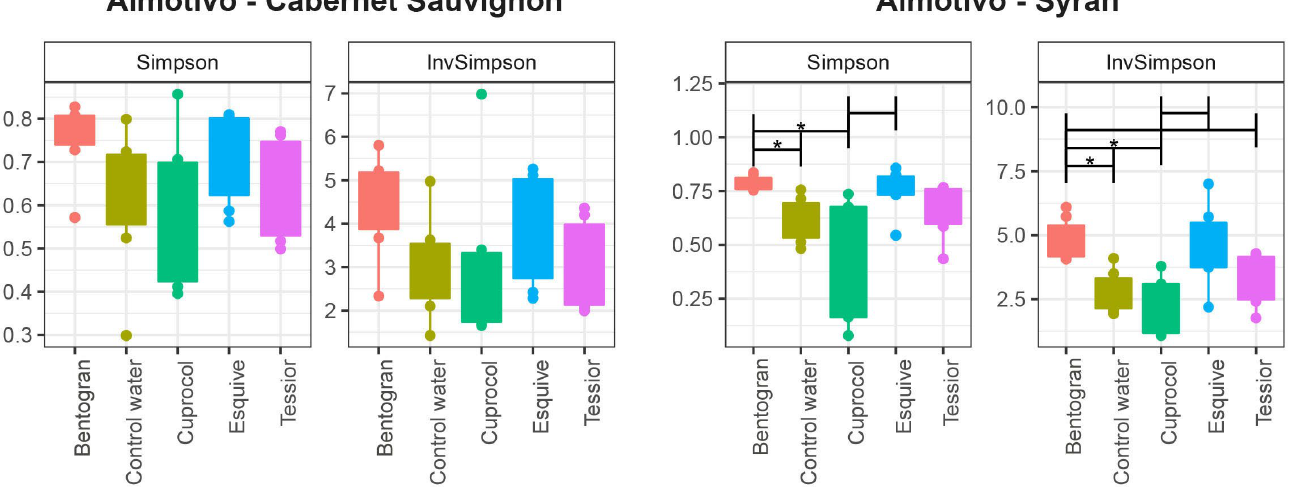
Figure 3. Box plots of alpha diversity indices (Simpson and InvSimpson) showing the richness of the fungal communities in canes treated with different prun ing wound protection products (Bentogran, control water, Cuprocol, Esquive and Tessior) in Cabernet Sauvignon and Syrah from the Almotivo and DISAFA vineyards. The horizontal brackets marked with an asterisk (*) indicate statistical differences, while brac kets without asterisks indicate trends (0.15 < p < 0.05). 3.4. Beta Diversity The Bray–Curtis dissimilarity represented in PCoA plots of the beta dispersion was used to evaluate the beta diversity of the wood mycobiome (Figures 4 and 5). When comparing cultivars, there are no significant differences between Cabernet Sauvignon and Syrah ( p > 0.05; Figure 4A). On the contrary, when comparing location, according to PERMANOVA, there are highly significant differences between the Almotivo and DISAFA vineyards ( p = 0.001; Figure 4B).